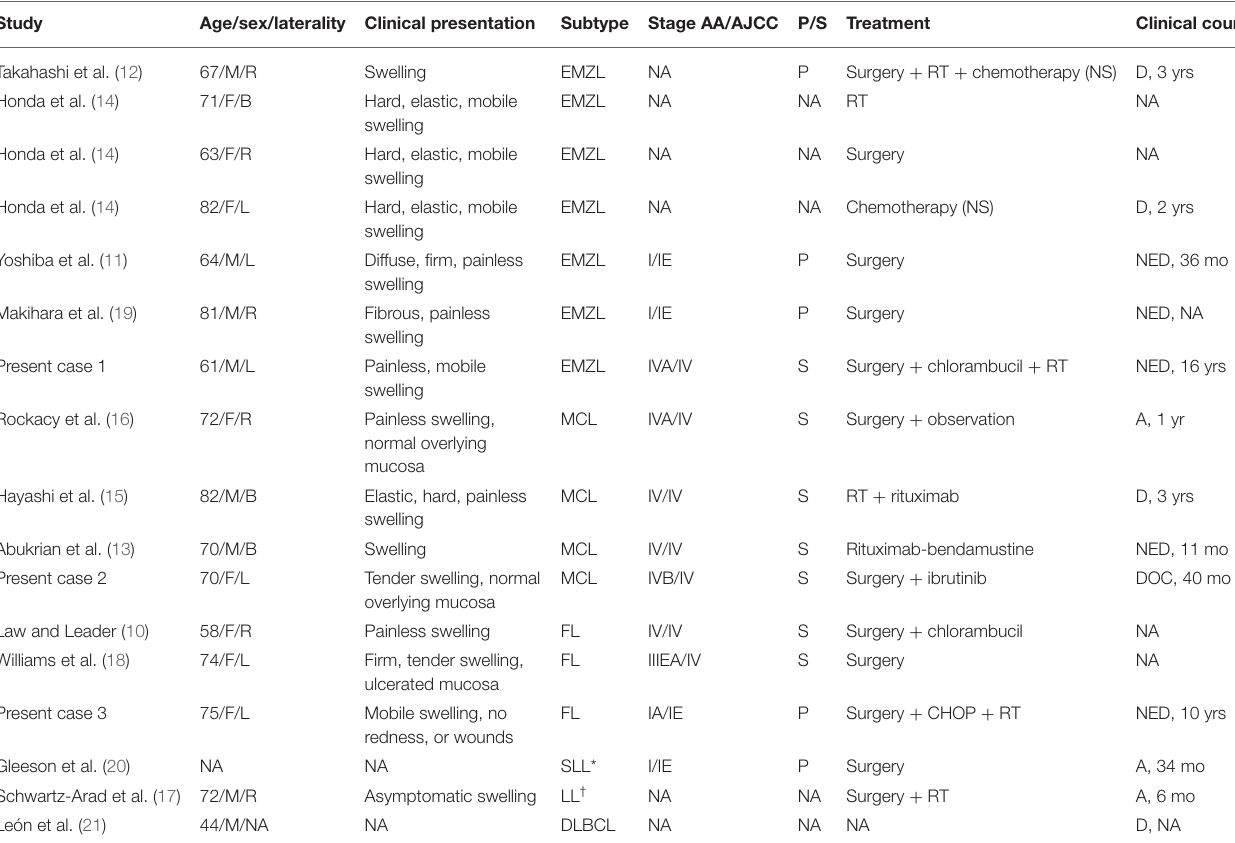
TABLE 1 | Demographic, clinical presentation, subtype, stage, treatment, and outcome of previously published sublingual gland lymphomas.